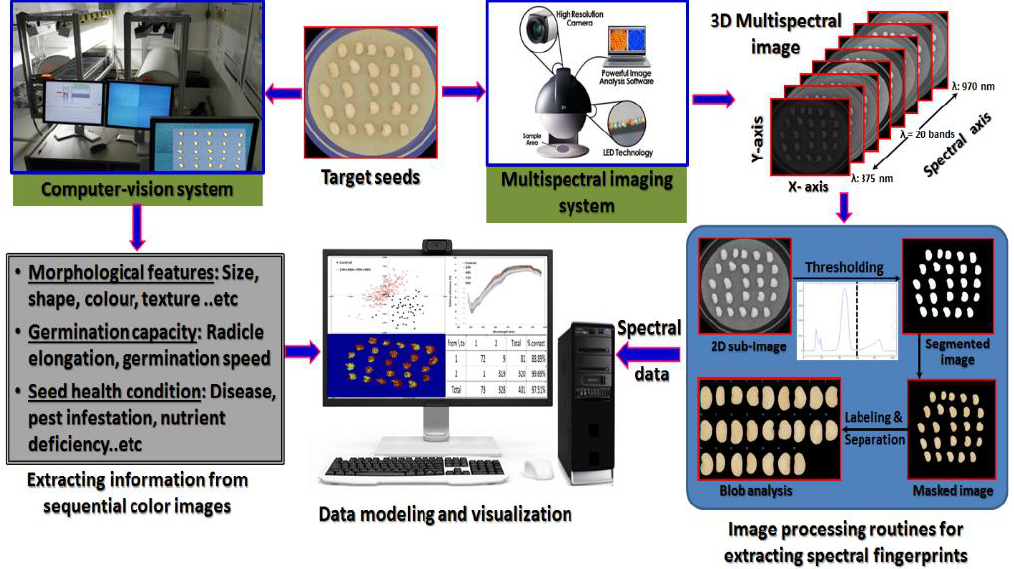
Figure 1. Schematic representation of a computer-aided image analysis system for seed quality evaluation based on computer-vision and multispectral imaging techniques.